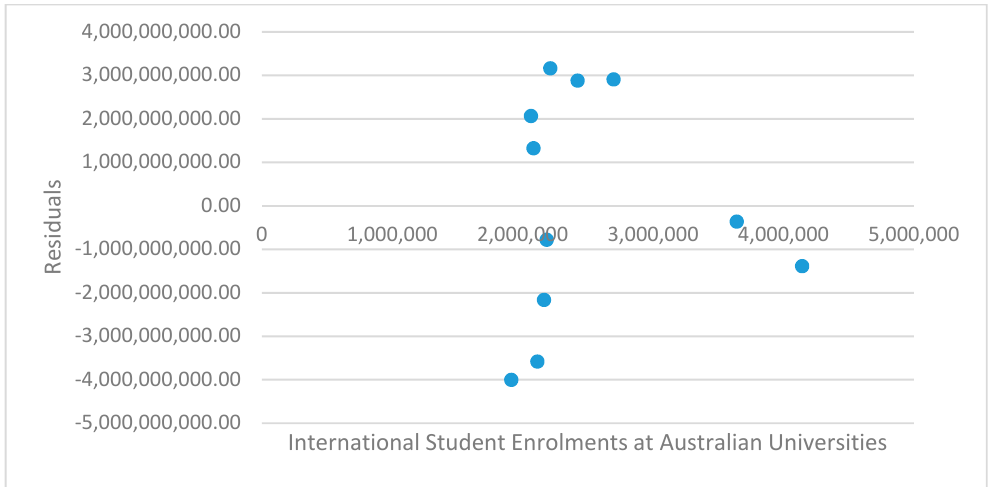
Figure 2. Residual Plot for International Student Enrolments and Total Australian University Revenue.